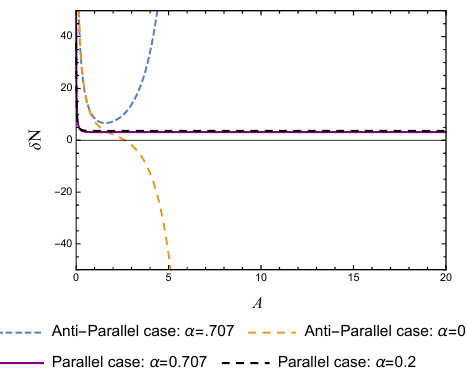
Figure 17 . Parallel and Anti-parallel motions in (1 + 1) dimensions with thermal background: δ N Vs A plot with ∆ E = 1 , the σ = 200 . a B